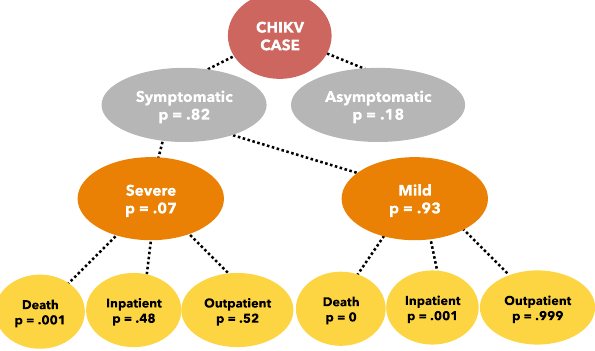
Figure 4. Decision tree used to classify simulated CHIKV cases. Transition probabilities to different states of the tree are reported in the